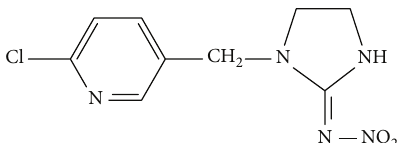
Figure 1: Structural formula of